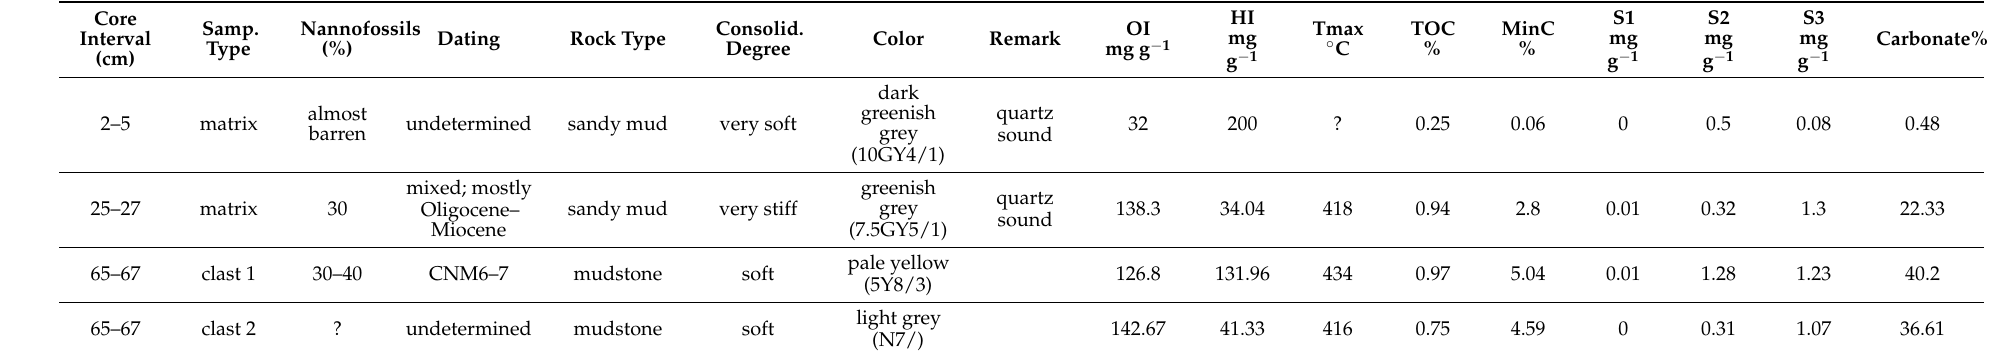
Table A2. Heraklion MV (LEV3GC